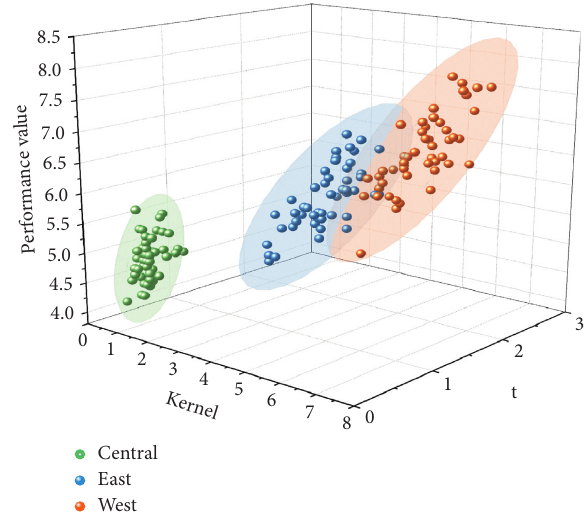
Figure 7: East, west, and central future development efficiency